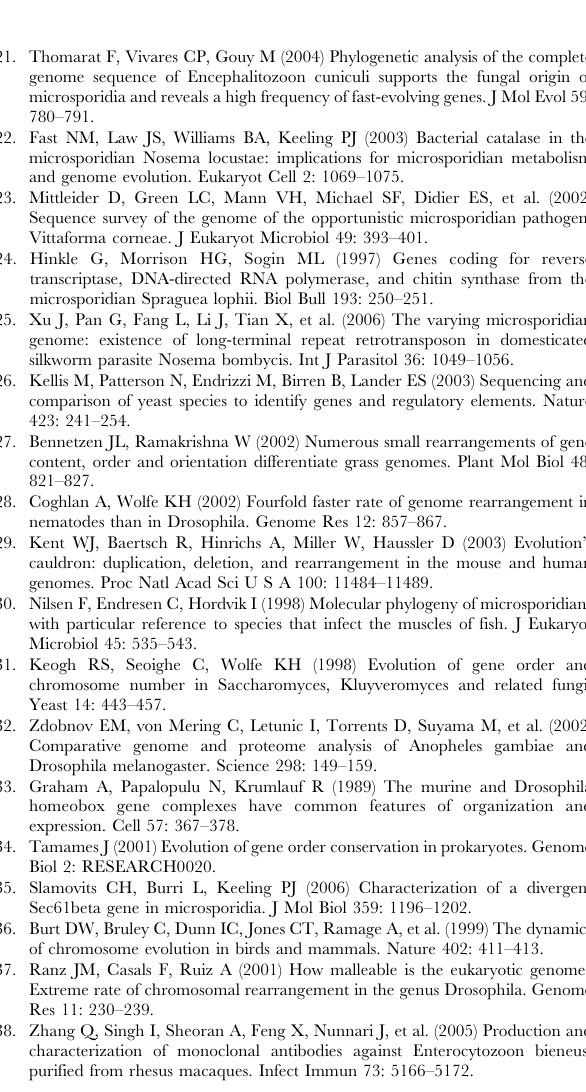
Table S1 Description of the ORFs, their position along the scaffolds, and the accession number of their best match against the E. cuniculi